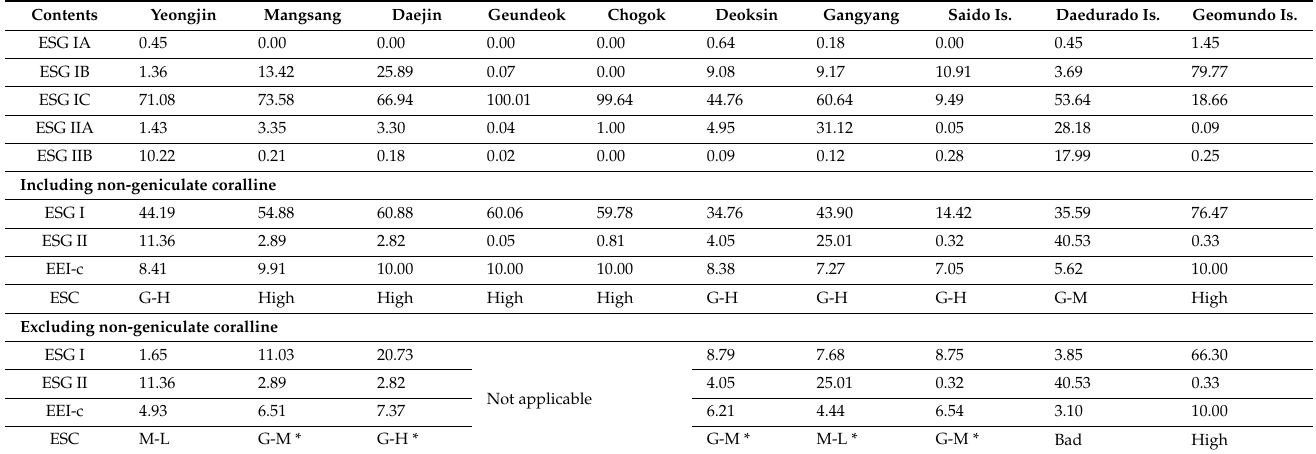
Table 4. Evaluation of the status of seaweed beds using EEI-c model at the study